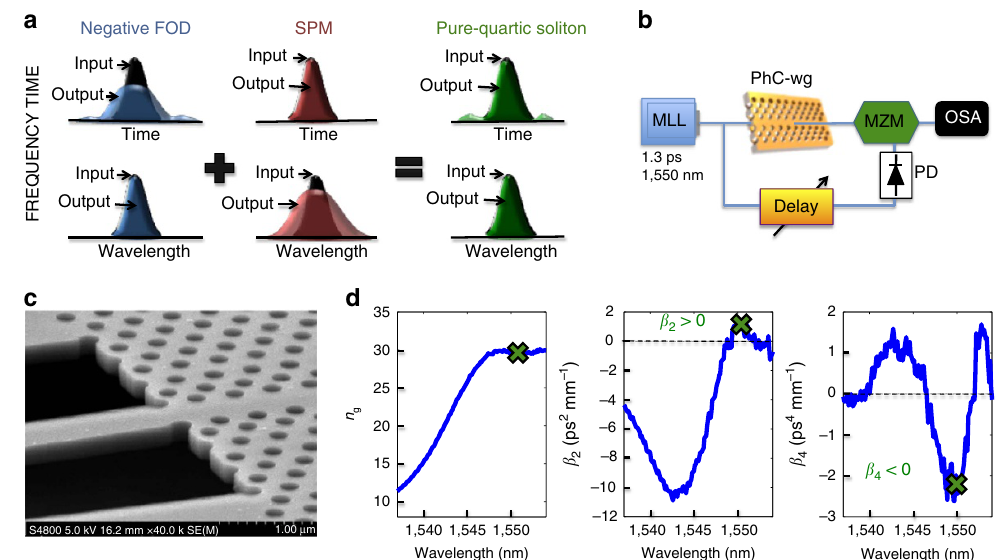
Figure 1 | Concept of pure-quartic solitons and their experimental demonstration. ( a ) Schematics of pure-quartic solitons: (Left) Fourth-order dispersion (FOD) gives rise to temporal pulse broadening (blue output pulse versus black input pulse in time) without affecting the spectrum; (Centre) self-phase modulation (SPM) generates spectral broadening (red output pulse versus black input pulse in frequency) without affecting the temporal pulse shape; (Right) the interplay of FOD and SPM can give rise to pure-quartic solitons which remain nearly unperturbed (green output pulses versus black input pulses in both frequency and time); ( b ) Frequency-resolved electrical gating set-up: mode locked laser (MLL), photonic crystal waveguide (PhC-wg), tunable delay, ultrafast photodiode (PD), Mach–Zehnder modulator (MZM), and optical spectrum analyser (OSA); ( c ) Scanning electron microscope image of the sample; ( d ) Measured dispersion of the silicon photonic crystal waveguide used in our experiments: group index ( n g ), second-order dispersion parameter ( b 2 ) and fourth-order dispersion parameter ( b 4